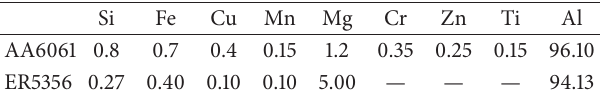
Table 1: Chemical composition in wt% of base metal AA6061 Al alloy and filler metal ER5356.